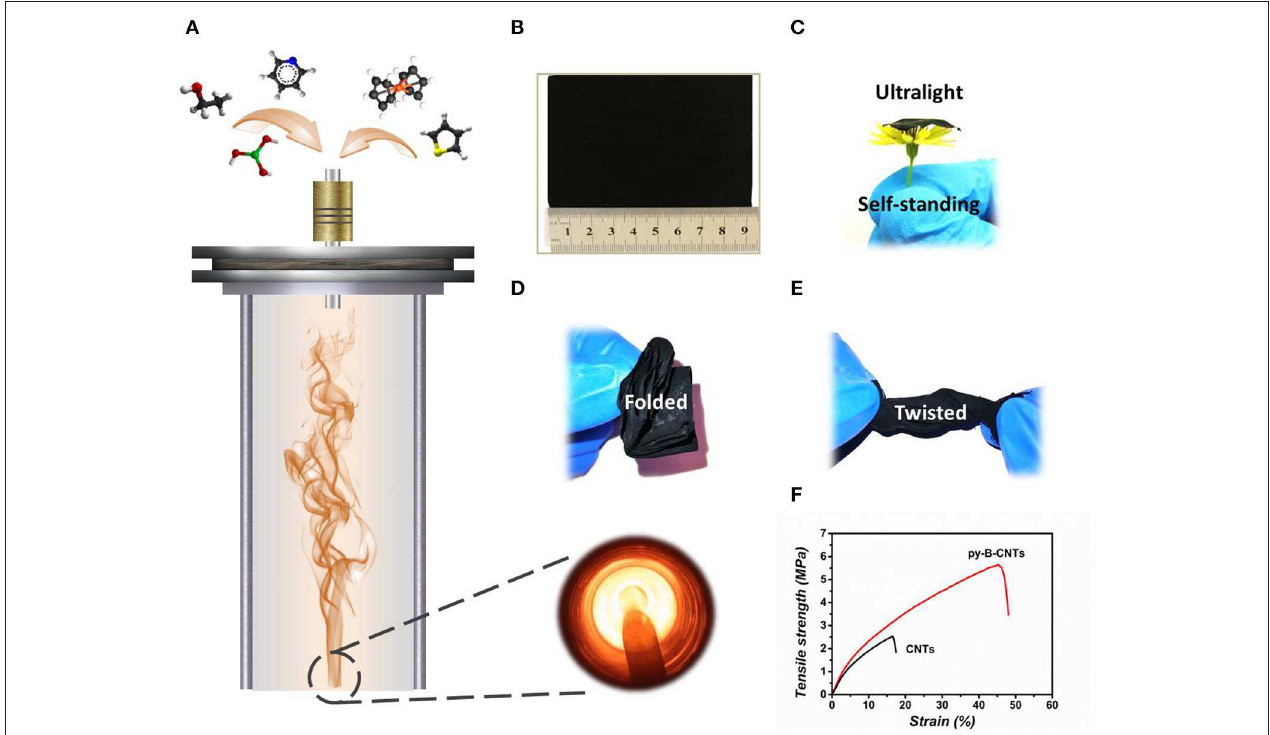
FIGURE 1 | Illustration of the fabrication and flexibility of the py-B-CNTs film. (A) Schematic illustration of the synthesis of the py-B-CNTs film from a vertical furnace and corresponding photograph taken from the bottom of the furnace tube; (B) optical image of a piece of py-B-CNTs film of ∼ 9 × 7cm; (C) optical image of the ultralight and self-standing film; (D,E) optical images of the film under various deformations; and (F) tensile strength curves of py-B-CNTs and pristine CNTs films.